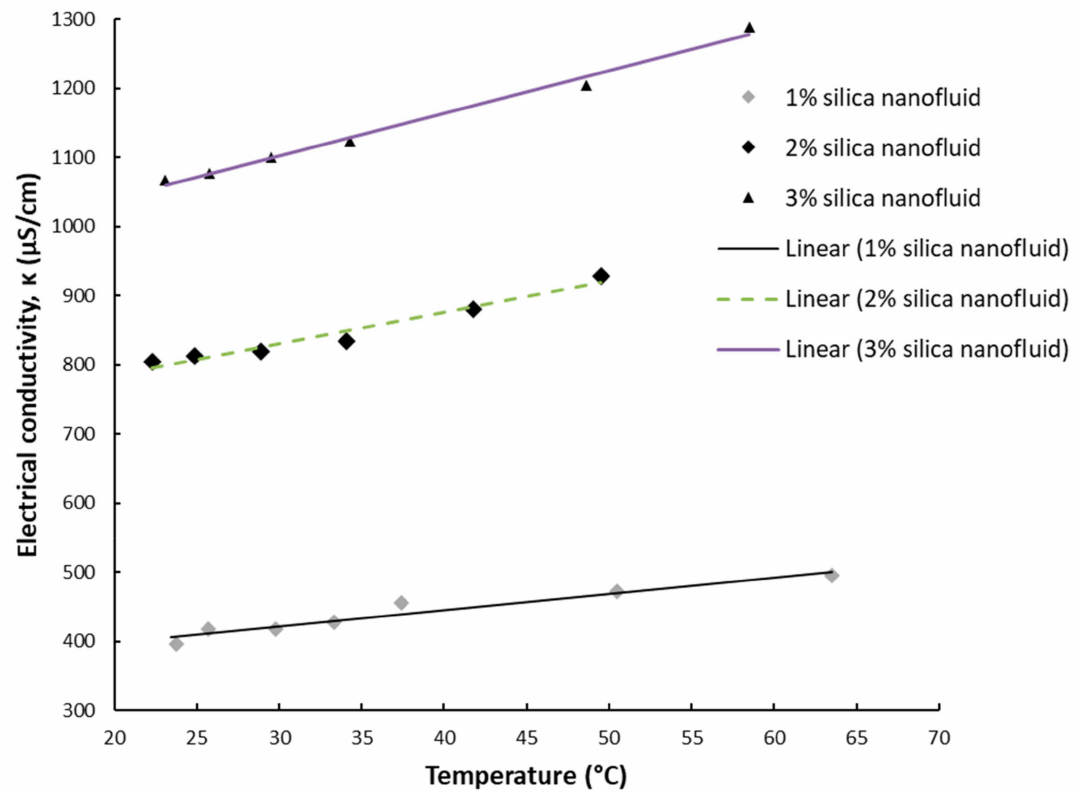
Figure 3. Experimental results on silica nanofluid electrical conductivity variation with